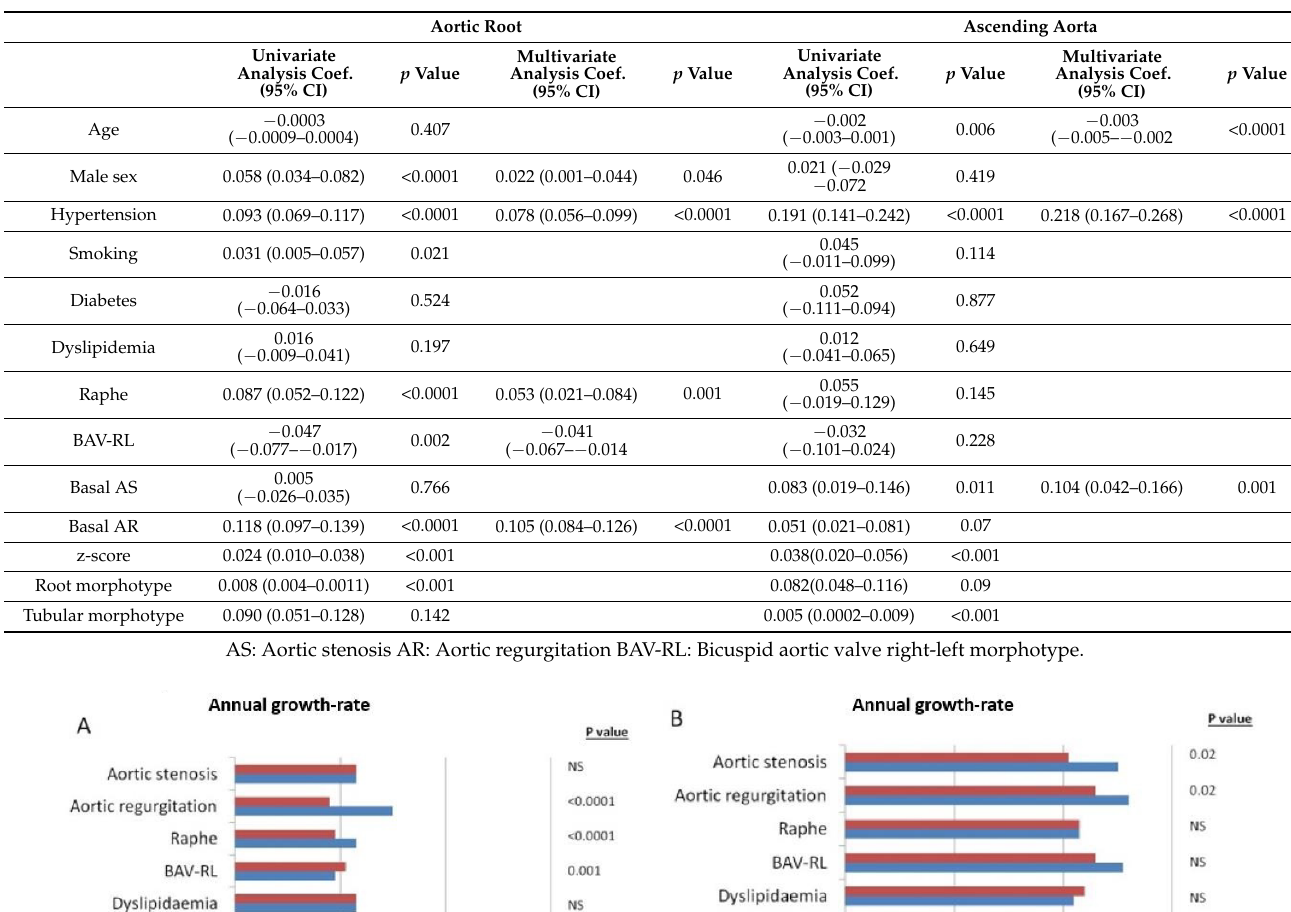
Table 2. Factors associated with annualized aortic diameter progression (mm/year) identified by univariate and multivari- able linear regression analysis.